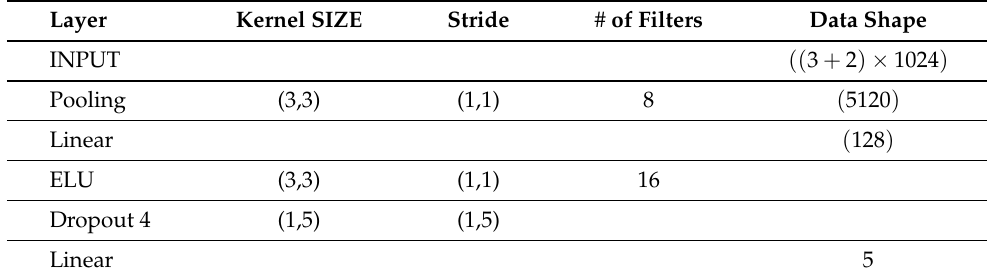
Table 3. Classifier detailed